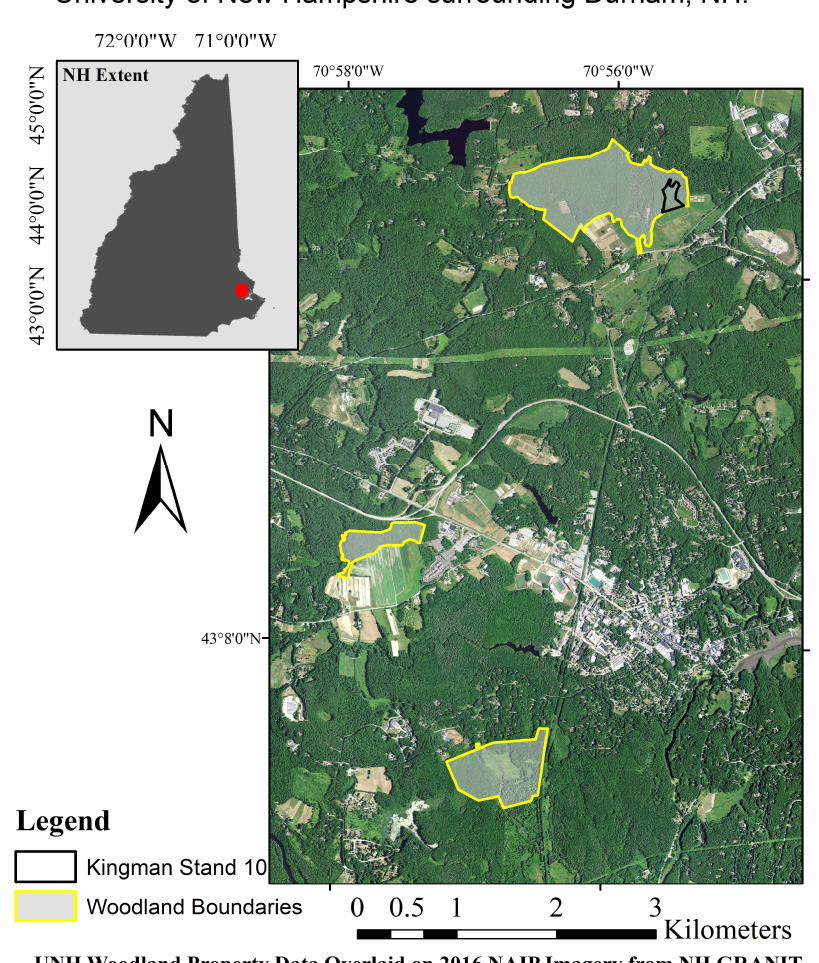
Figure 1. Study areas selected for comparing flying height influences on Structure from Motion (SfM) processing success and comparing processing outcomes between Pix4D and Agisoft PhotoScan. All three study areas are located in the Seacoast Region of New Hampshire with Kingman Farm being the northern most woodland, Moore Field to the west, and West Foss Farm to the south.